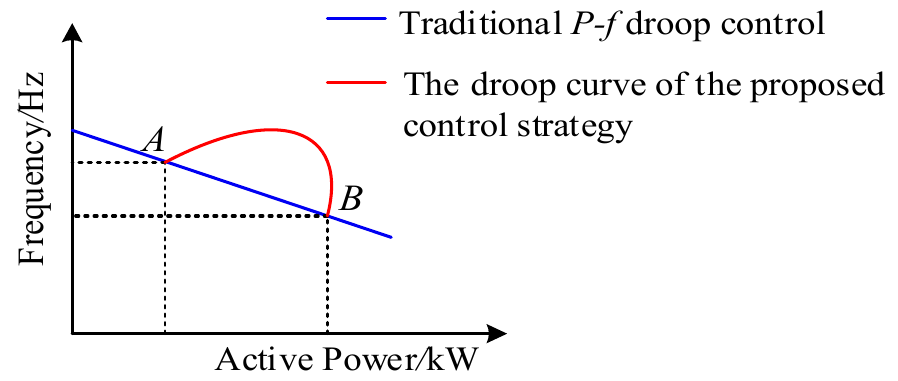
Figure 6. Comparison of frequency characteristics in transient process between traditional droop control and the proposed control method.